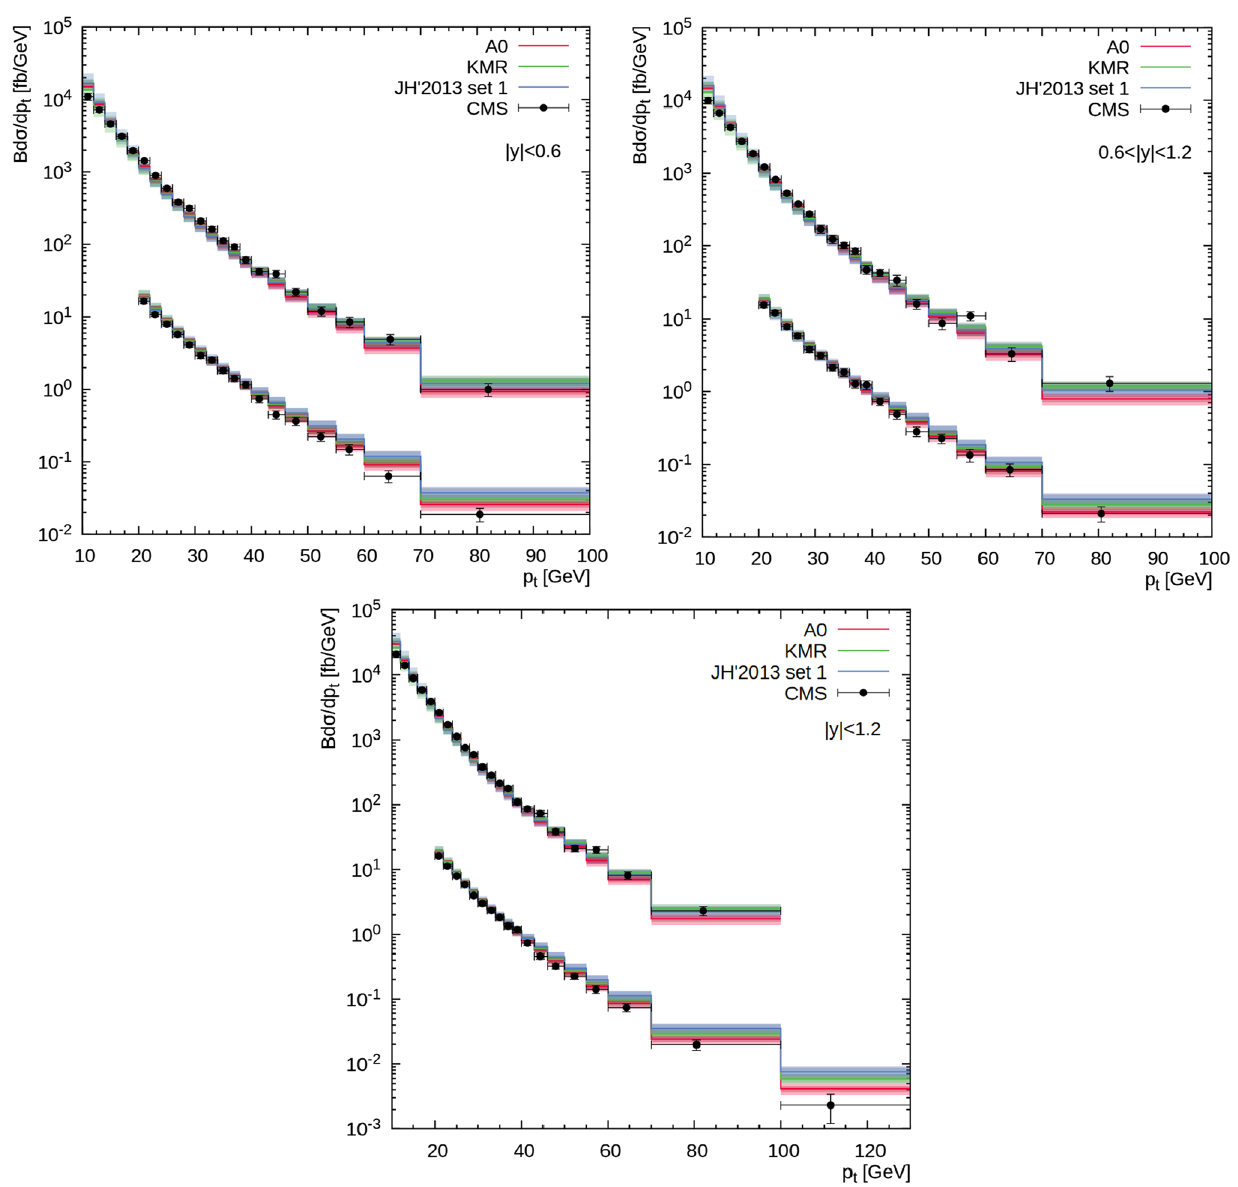
Fig. 4 Transverse momentum distribution of inclusive ϒ( 3 S ) pro- √ s = 7 TeV (upper histograms) and √ duction calculated at s = 13 TeV (lower histograms, divided by 100) in the